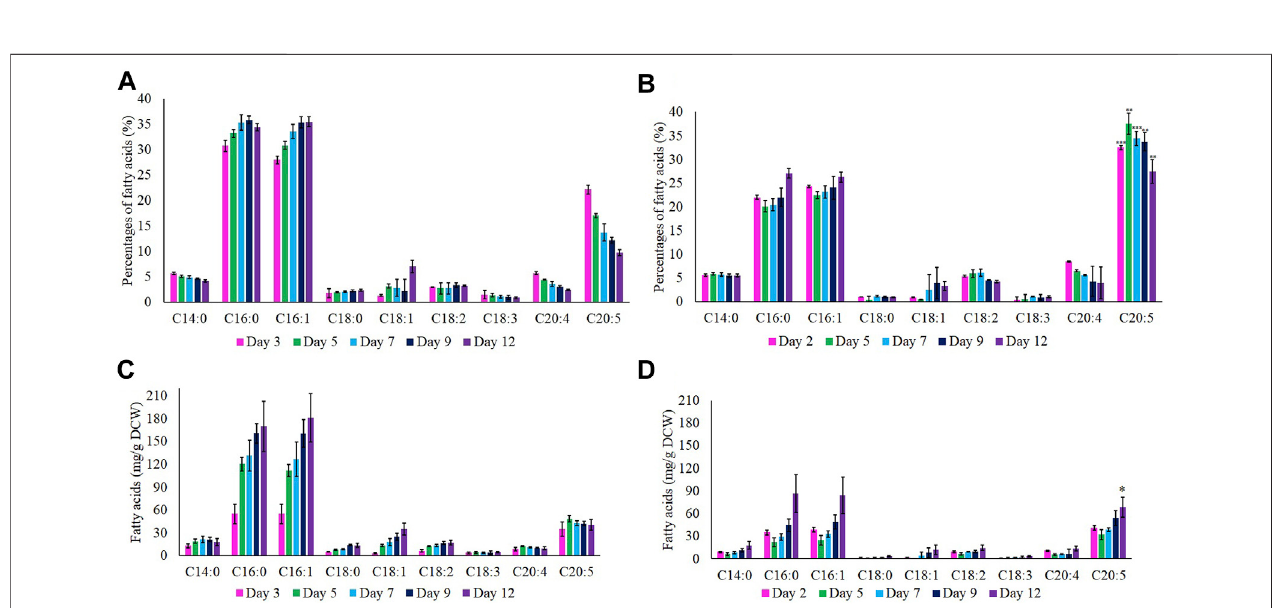
FIGURE 5 | Percentages (%) of fatty acids at day 12. (A) Wild-type and (B) M1 mutant N. oculata . Quanti fi cation (mg/g) of fatty acids at day 12. (C) Wild-type and (D) M1 mutant N. oculata . Mean ± standard deviation is shown (n = 3) and t-tests determine the statistical signi fi cance ( p < 0.05 [*]; p < 0.01 [**]; p < 0.001 [***]) for EPA content in the M1 mutant strain compared to the wild-type